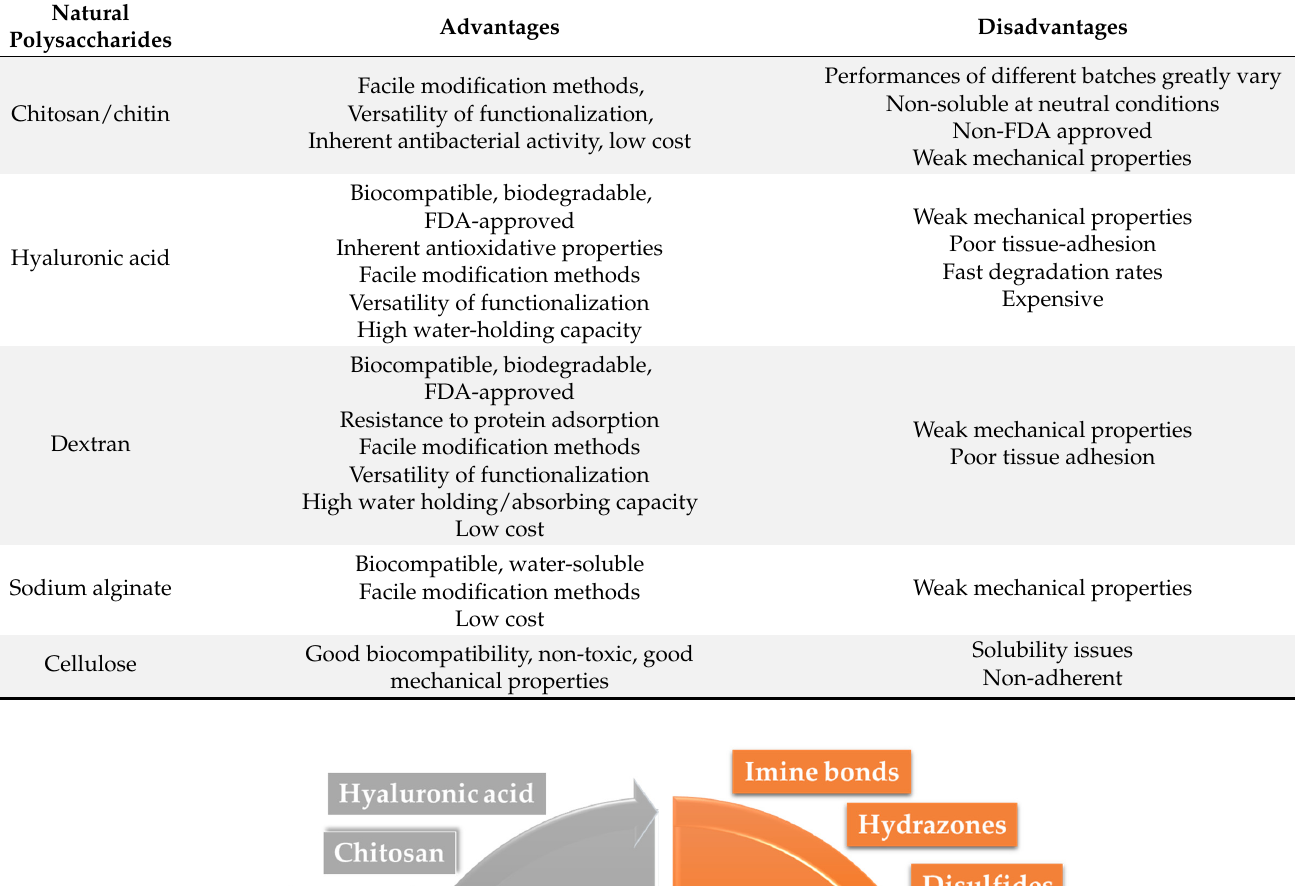
Table 1. Major advantages and disadvantages of basic natural polysaccharides used in stimuli responsive wound healing applications.